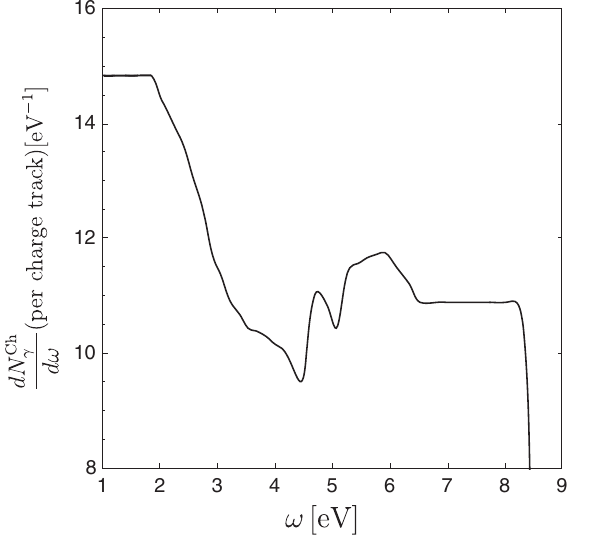
FIG. 19. The estimated n -electron event rate from Cherenkov radiation at SuperCDMS HVeV (blue line) based on a simple model with several assumptions and a photon detection proba- bility f ≈ 1 . 6 × 10 − 3 (see the text for details). The experimental data with 100 V bias voltage are shown in black with the error bars corresponding to the 3 σ statistical uncertainty